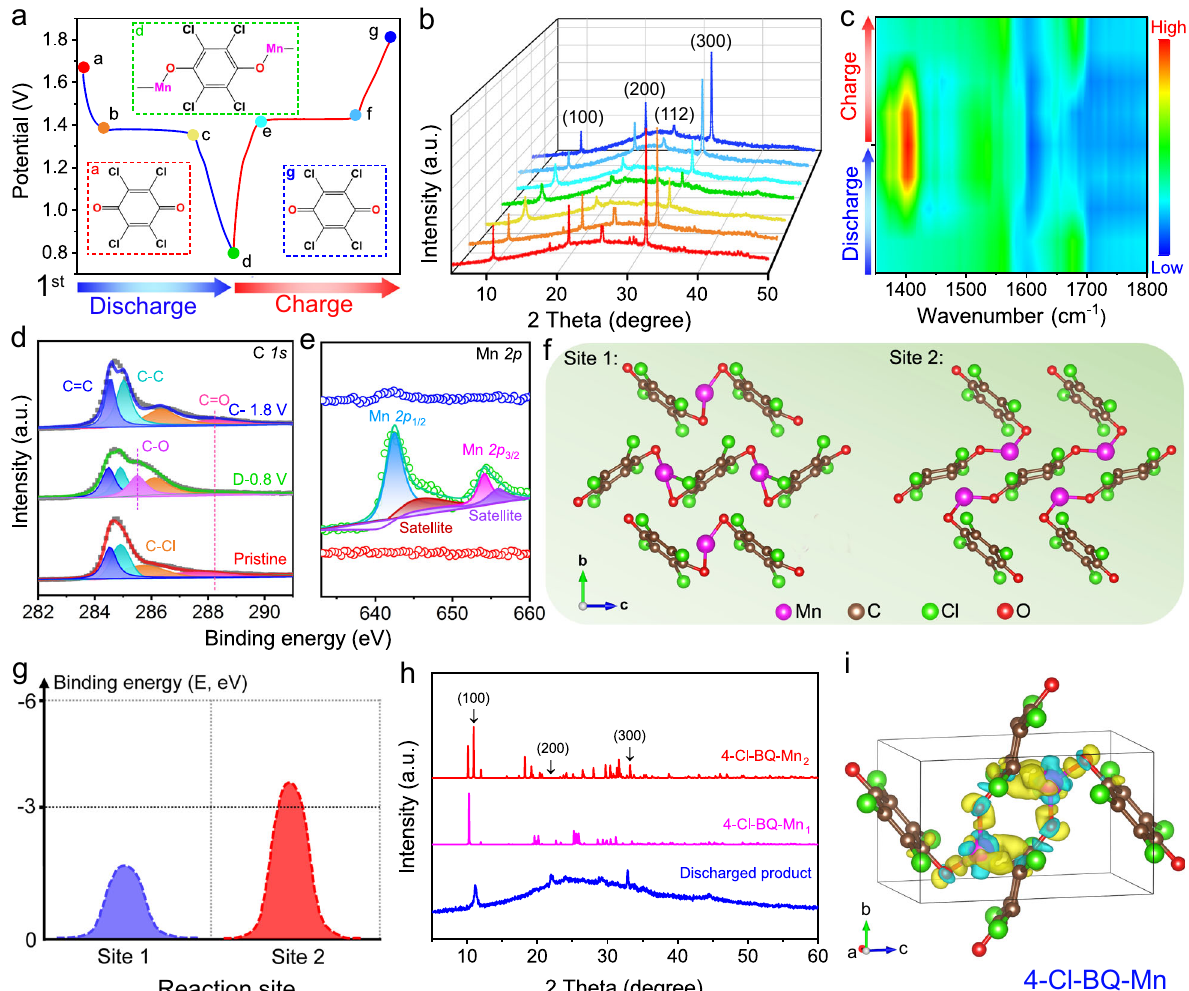
Fig. 5 Mn 2 + ion coordination mechanism in 4-Cl-BQ electrodes. a The fi rst GCD curve at 50 mA g − 1 . Inserts are the schematic diagrams of 4-Cl-BQ molecules at different discharge/charge states. b XRD patterns, c FTIR, XPS spectra of d C 1 s and e Mn 2 p at different discharge/charge states. f Schematic diagram and g calculated binding energy of two possible coordination sites of Mn 2 + ions in 4-Cl-BQ crystals. h The predicted XRD patterns of two possible coordination sites and the XRD pattern of the discharged product. i Differential charge densities of Mn 2 + ion coordinated 4-Cl-BQ crystals. Blue and yellow indicate electron accumulation and depletion,